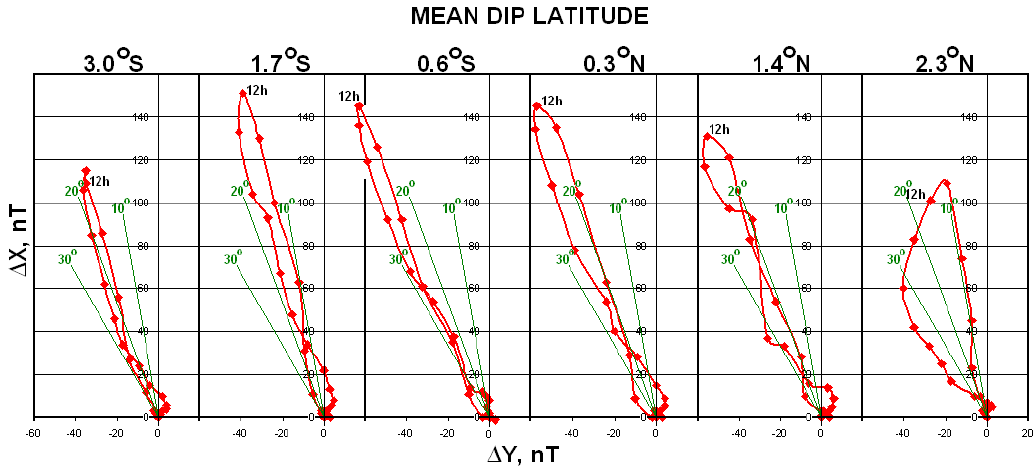
Fig. 5b. Plots showing the 1X versus 1Y loop of the Sq variations at each of the selected group of stations.